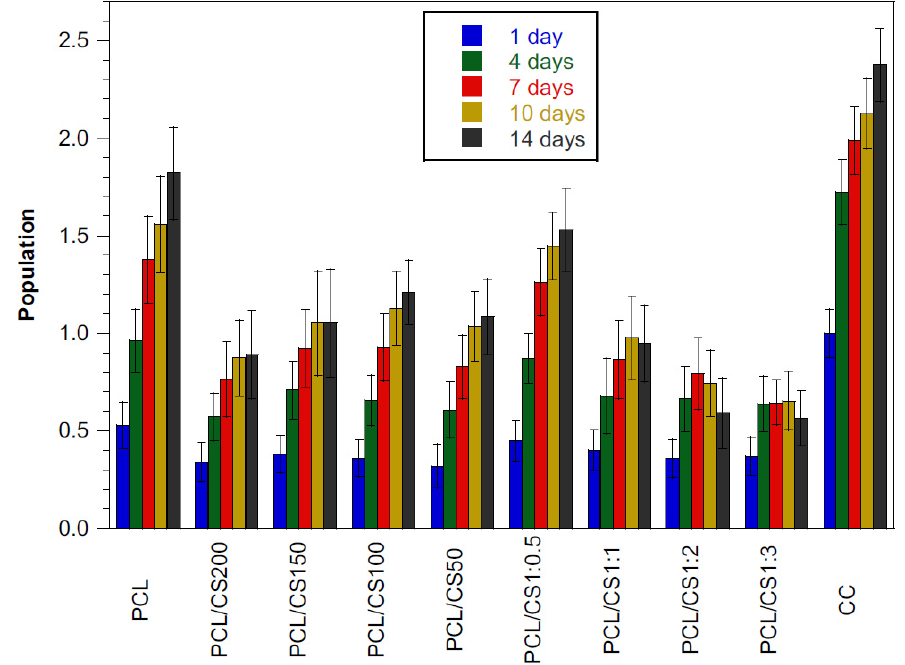
Figure 7. Cellular viability of HFFF2 cells seeded on PCL mats, PCL mats with CS flakes of different size ranges, PCL mats with different PCL to CS mass ratios and tissue culture plate wells (CC). Viability was evaluated using resazurin on days 1, 4, 7, 10 and 14. Vertical lines represent the standard deviation of the mean ( n =